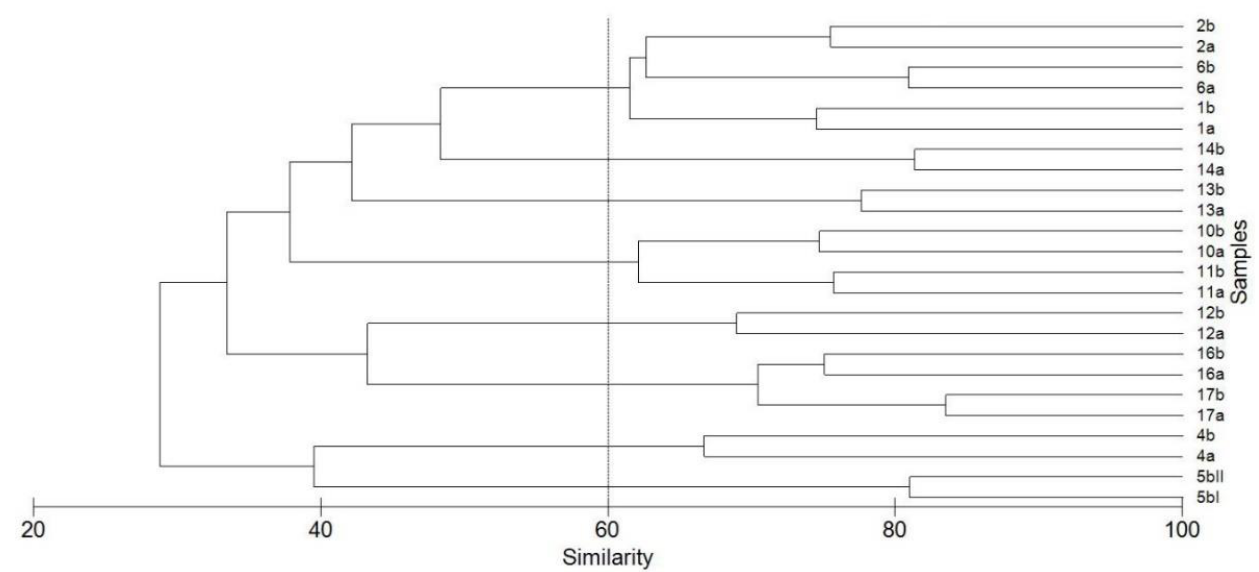
Figure 37. Similarity between the epiphytic diatom assemblages from Revillagigedo Archipelago according to the Bray– Curtis index based on the relative abundances of the shared taxa.